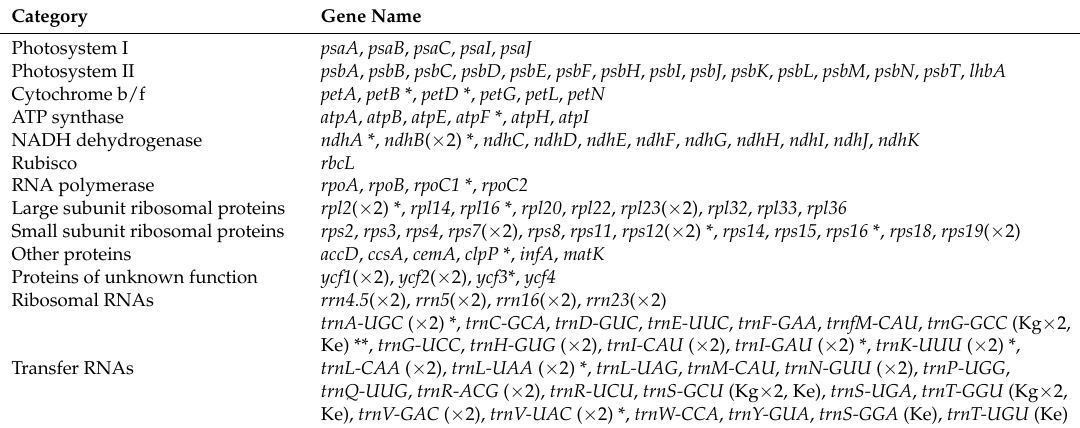
Table 2. Genes present in the chloroplast genomes of K. galanga and K. elegans